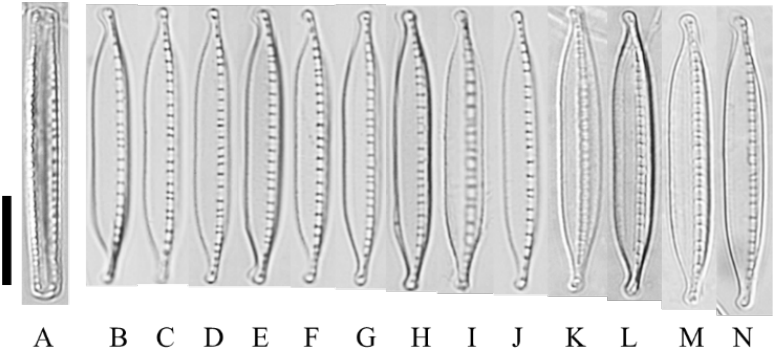
Figure 10. Light microscope photo of Nitzschia inclinata sp. nov. taken from holotype population (AG9004): ( A ) girdle view; ( B – N ) valve view; scale bar = 10 µ m. Description: Valves are narrow linear, and valve apices are capitate and slightly bent to one side. Length 32–34.5 µ m, width 3.5–5 µ m, 7–10 fibula in 10 µ m, 50 striae in 10 µ m, and 60–80 areolae in 10 µ m. Striae are uniseriate, parallel, and not observed under LM. Areola on the valve is loculate in type and circular in shape. The terminal fissure is located at each valve apex with a broad sweeping curve, and a helictoglossa is formed inside the valve. Fibula is to one side of the valve face and is irregular in width. Conopeum is positioned on the external valve face along the fibula. On the face of the conopeum, circular areolae form one line, but for the valve apices, the number of areolae increases